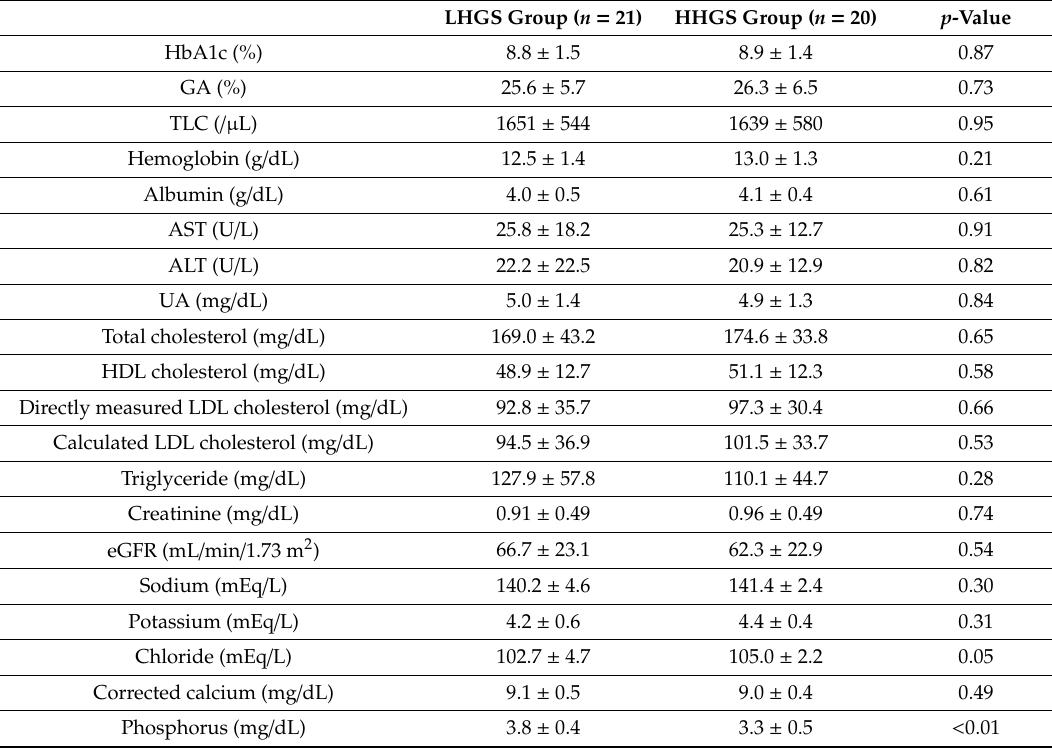
Table 3. Laboratory parameters.